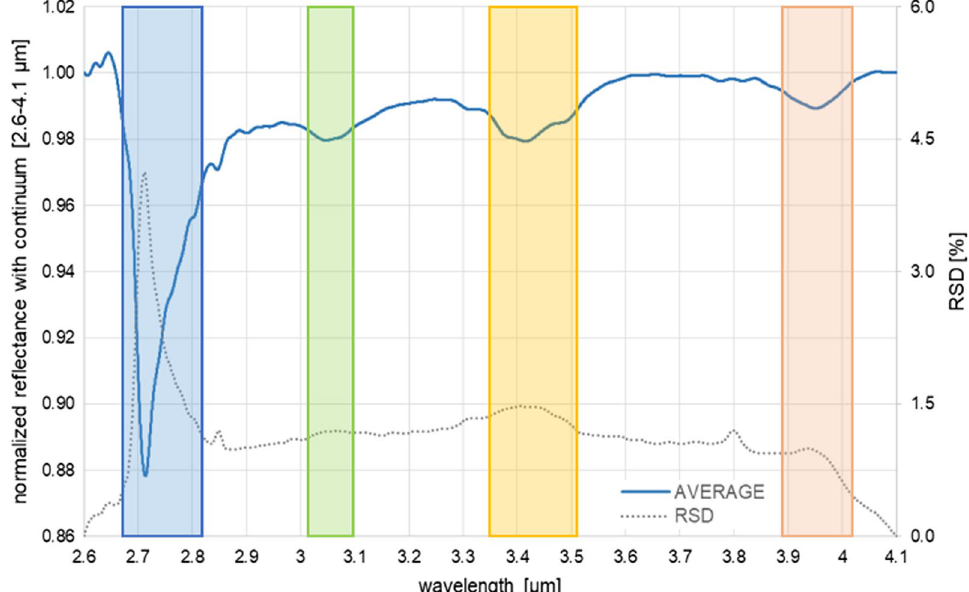
Fig. 8 Averaged spectrum of individual grains included in main group in the PCA plot. Relative standard deviation is also plotted with the dashed line. The spectrum is represented by absorption bands at 2.7 μm (blue), 3.05 μm (green), 3.4 μm (orange), and 3.95 μm